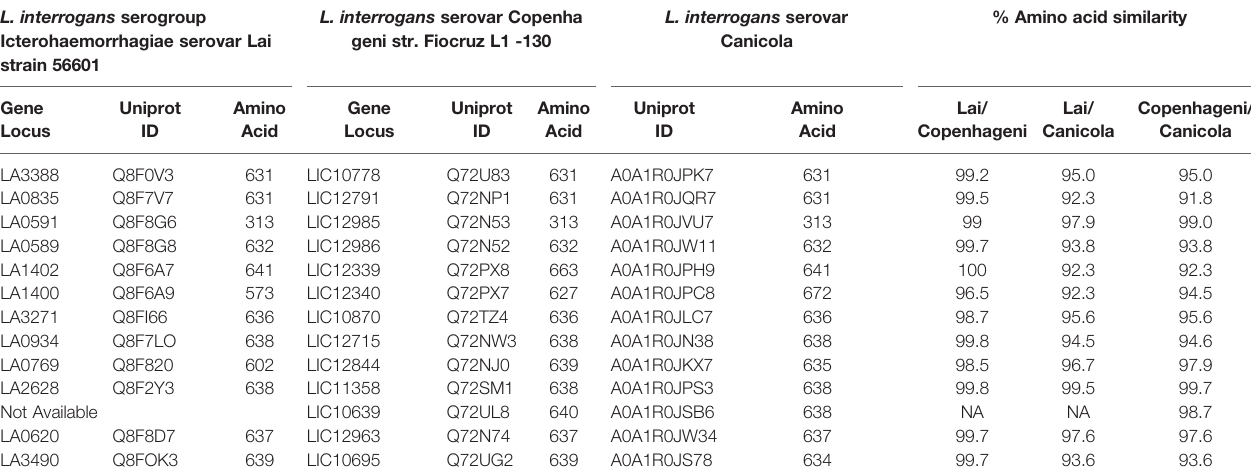
TABLE 1 | Orthologs and percentage amino acid similarity of PF07598 gene family members in Group I pathogenic Leptospira.